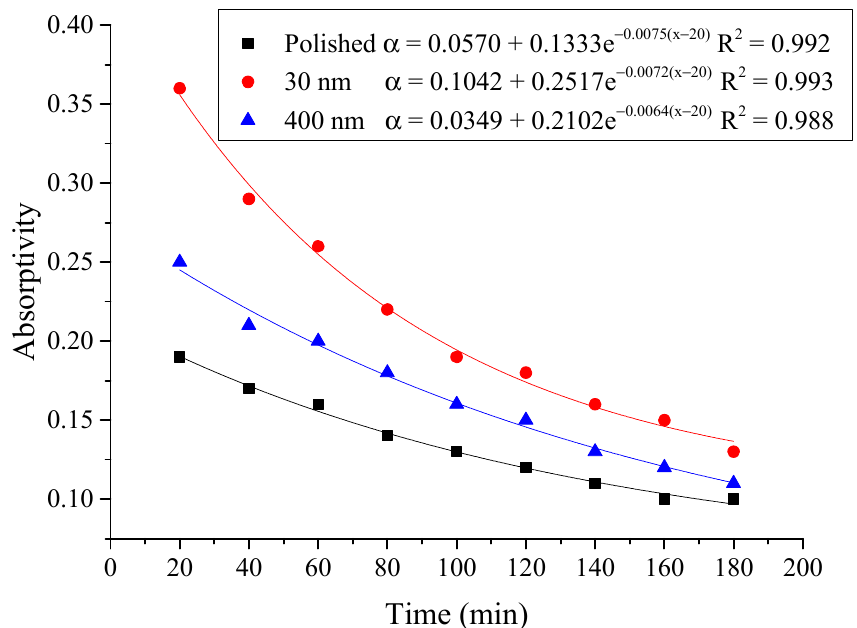
Figure 20. Variation of the average absorptivity for the testing rigs operated under the simulated radiation of 700 W/m 2 .